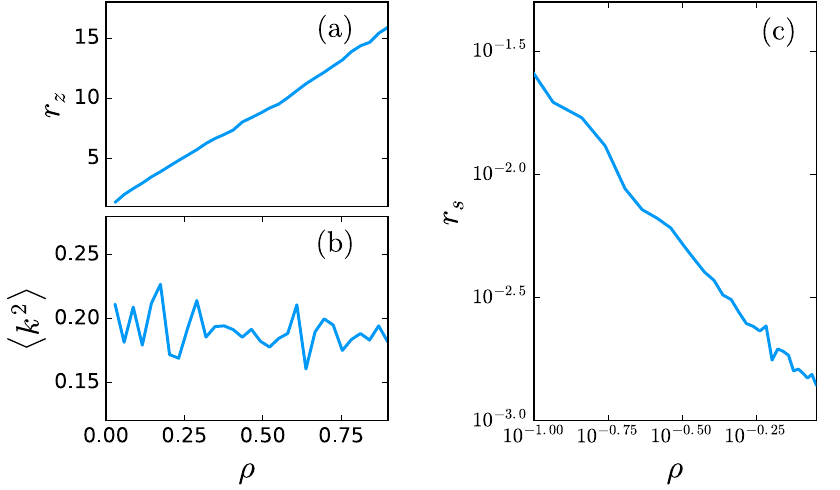
Figure 2. Influence of the density ρ of the graph. The figure shows the effect of the density ρ = 〈 k 〉 /( n − 1) of a random graph on the optimized delays results. The panels represent in ( a ) the ratio r z = n z /( n − 1), in ( b ) the variance of the vertex degree 〈 k 2 〉 , and ( c ) the ratio r s . The ratio r z is directly proportional to ρ and r s is inversely proportional to ρ . The simulations have been averaged over 40 realizations of a network with 70 vertices for each value of ρ .